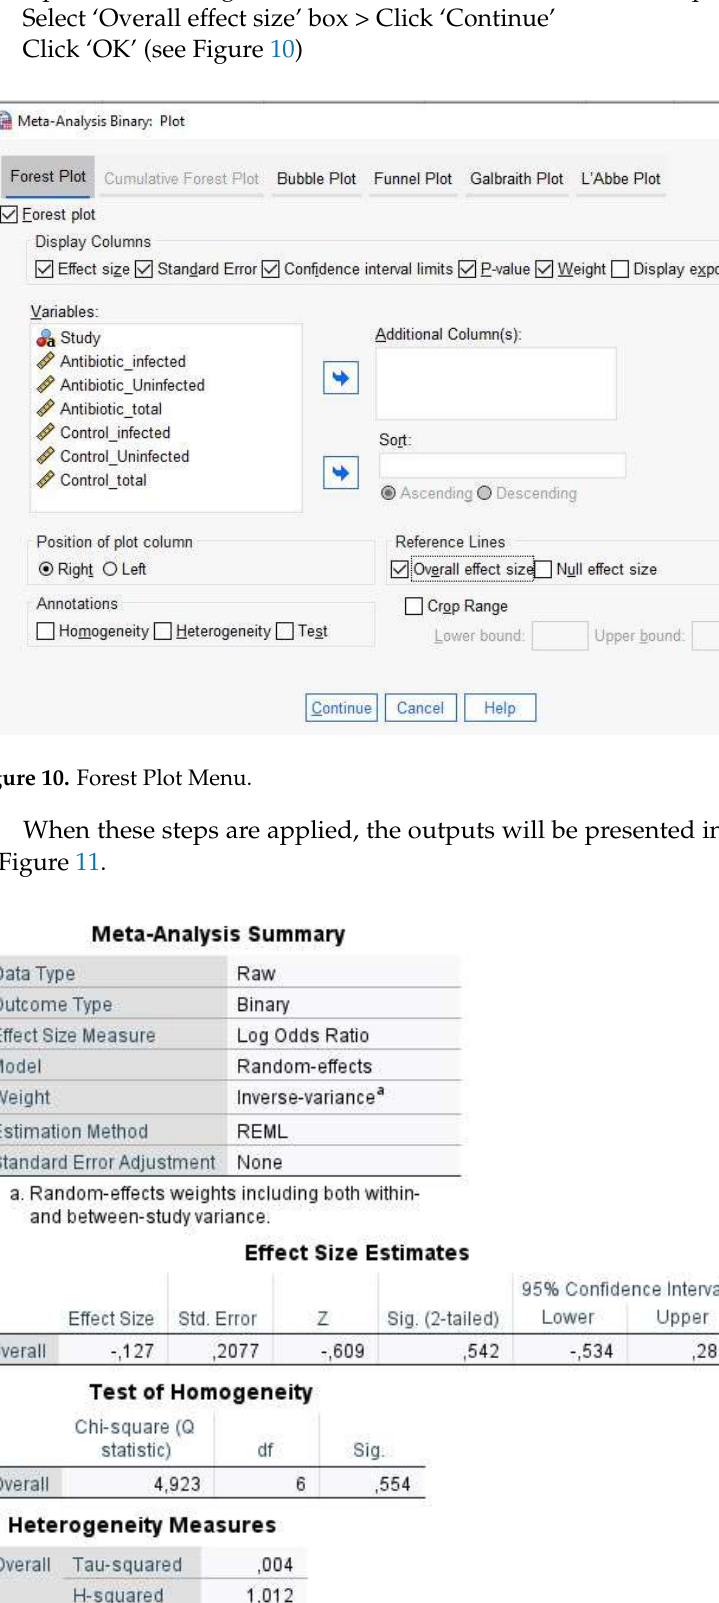
Figure 9. Data identification menu.